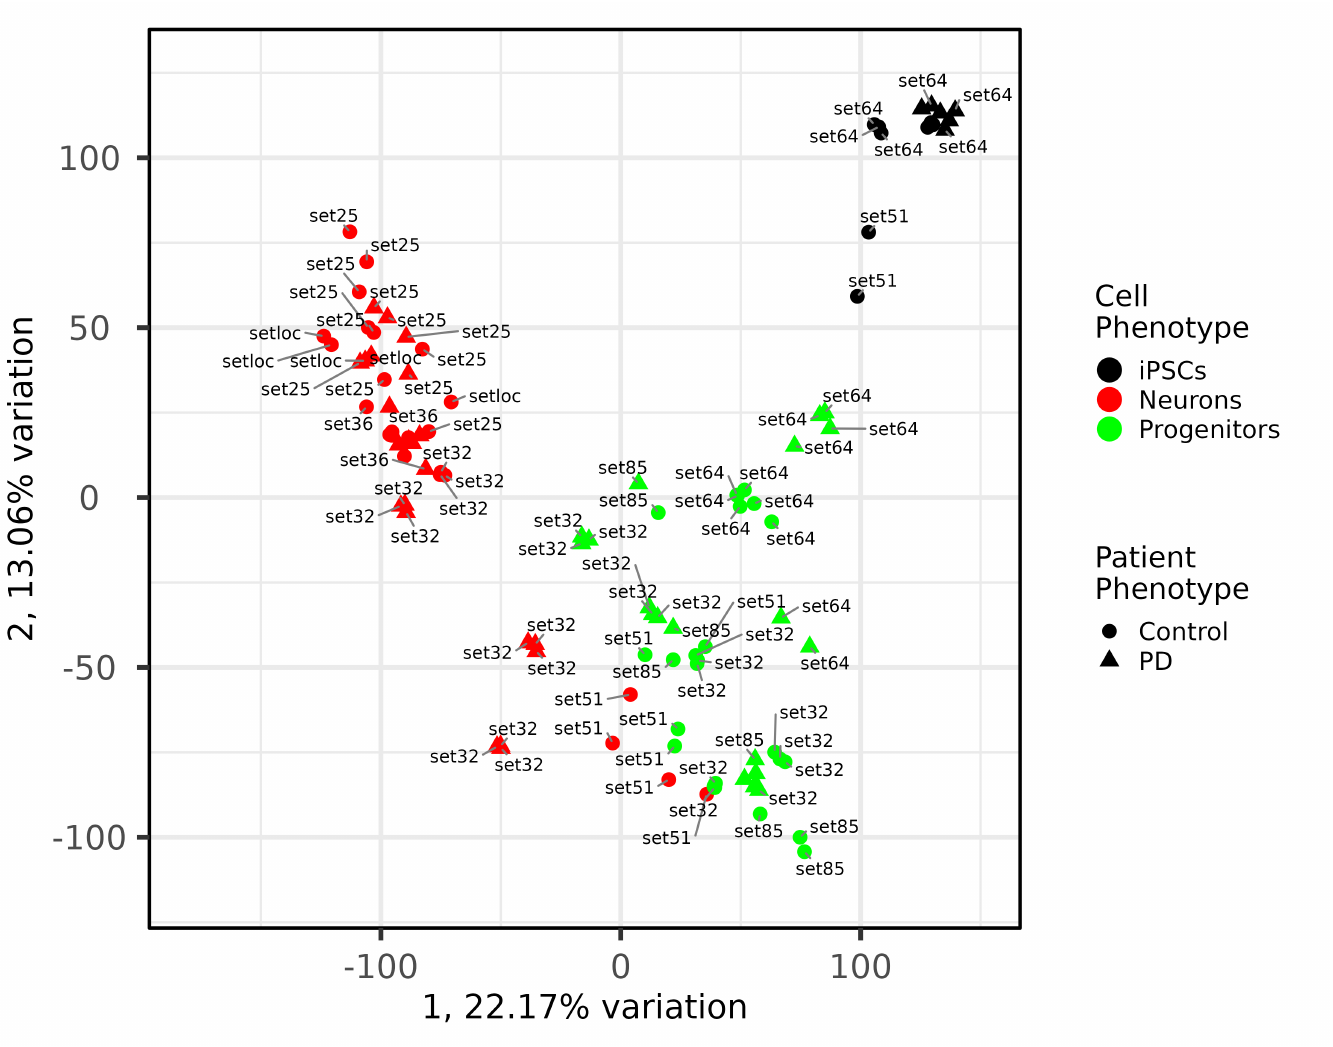
Figure 8. PCA plot of comparing samples in 7 datasets. Samples mostly cluster according to their cell